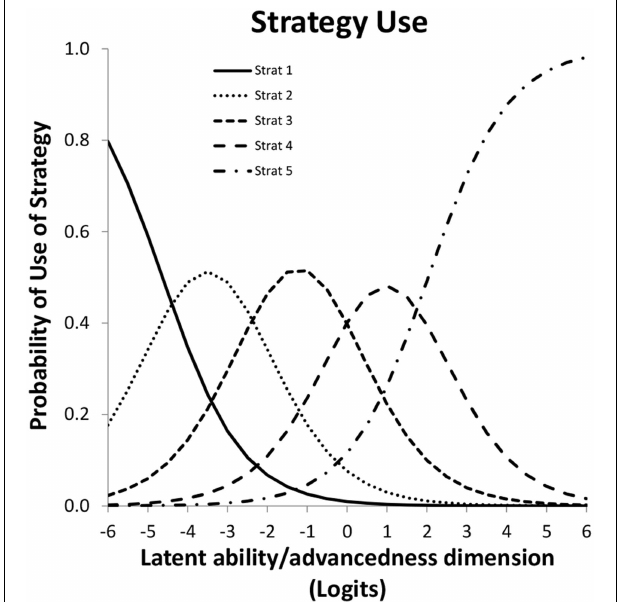
FIGURE 3 | Item characteristic curves for a five-category polytomous